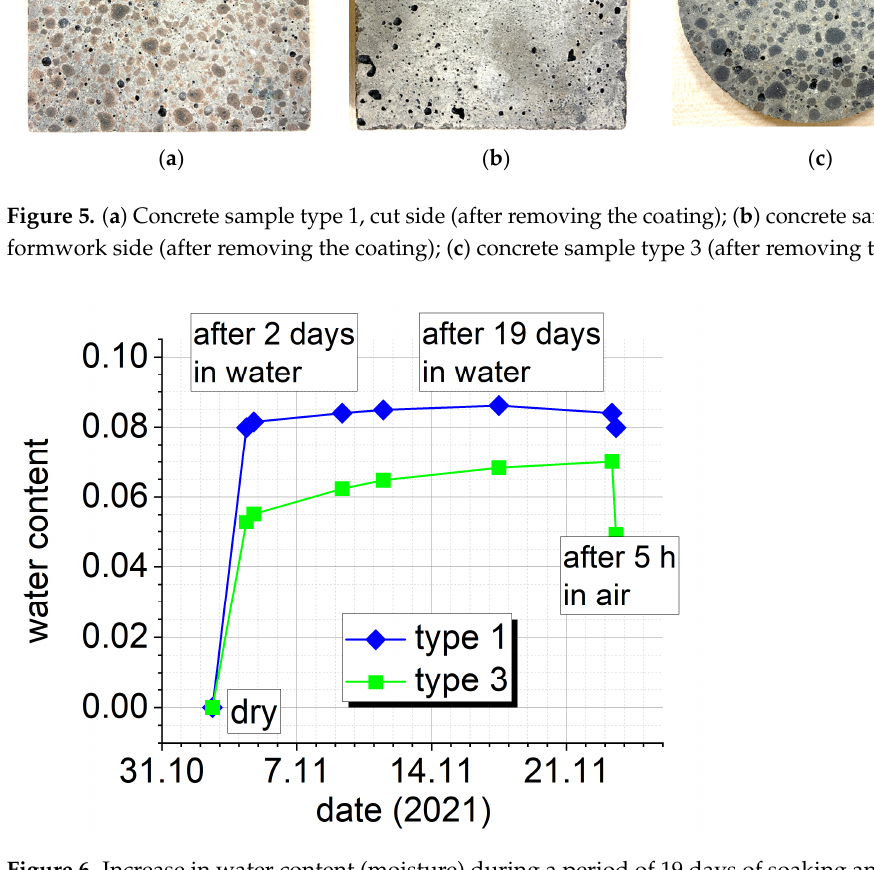
Figure 6. Increase in water content (moisture) during a period of 19 days of soaking and a sudden drop after 5 h drying in air.